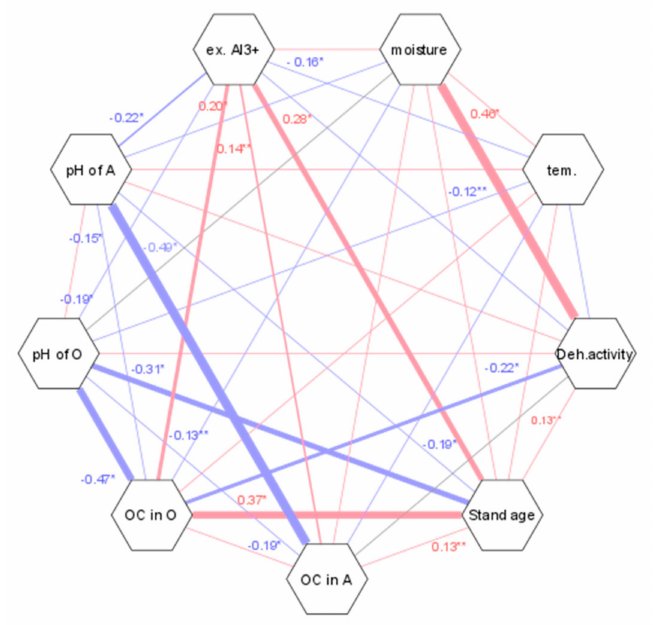
Figure 3. Correlation network analysis between analyzed soil characteristic ( n = 196). The correlation network was built using Pearson correlation coefficients and visualized in Cytoscape 3.8.2. The thickness of the edges is proportional to absolute value of Pearson correlation coefficients (red— positive correlations; blue—negative correlations; *: p < 0.05; **: p <